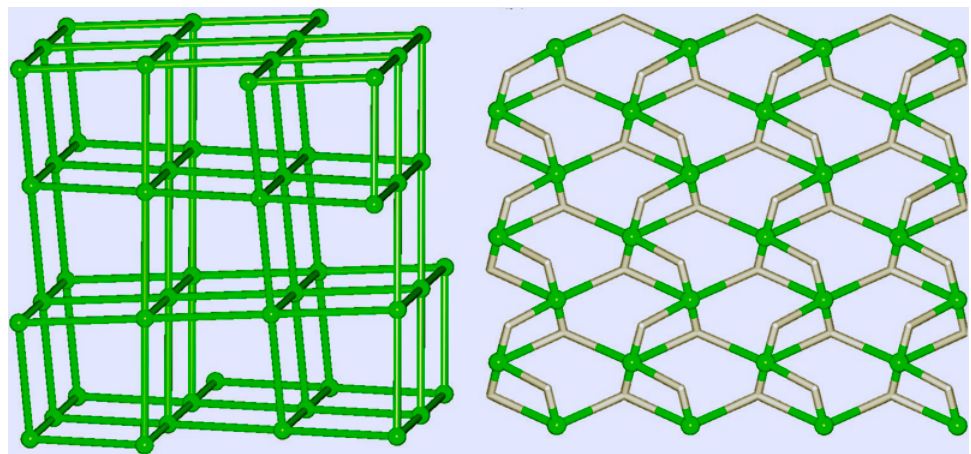
Figure 15. Topological representations of the H-bonded networks in catalysts 19 (left) and 20 (right). Green balls correspond to centroids of 6-connected or 5-connected molecular nodes. Adapted from Ref. [241].